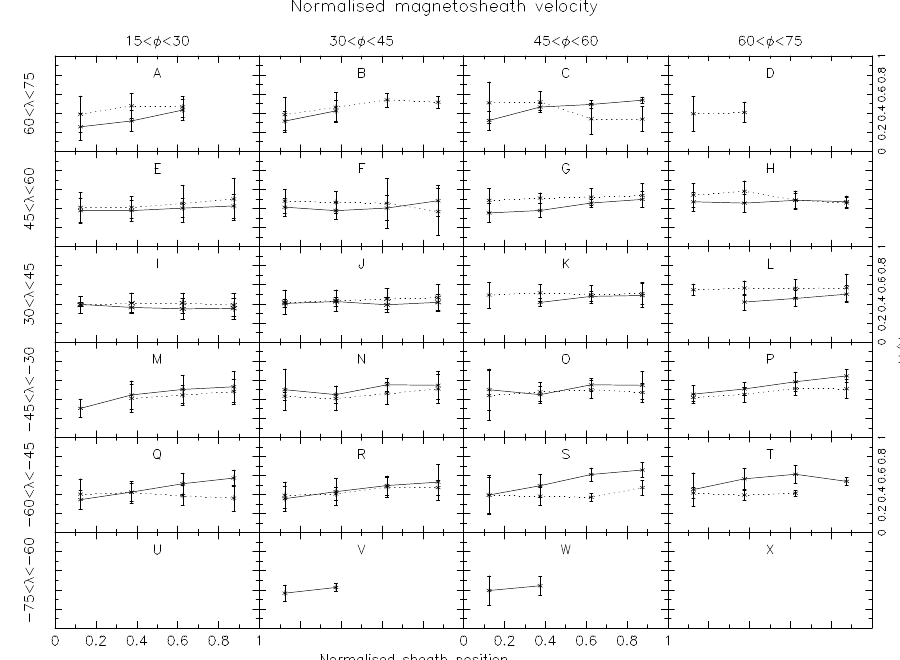
Fig. 6. The Fig. shows a matrix of panel plots of normalised velocity ratios with the absolute value of GSE longitude, φ increasing from left to right and GSE latitude, λ decreasing from top to bottom. Each panel in the figure shows the normalised velocity for a radial cross section of the magnetosheath, where the magnetopause is at 0.0 and the bow shock at 1.0. The solid lines indicate the results for the dawn side and the dashed lines show the results for the equivalent bins at dusk. Points which are absent from these plots indicate a lack of coverage for that particular bin. The error bar is the standard deviation of the velocity estimate.